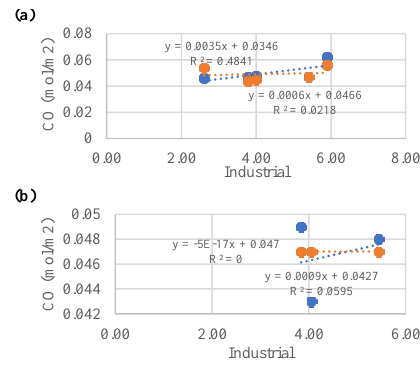
Figure 18. Influence of industrial landuse on CO